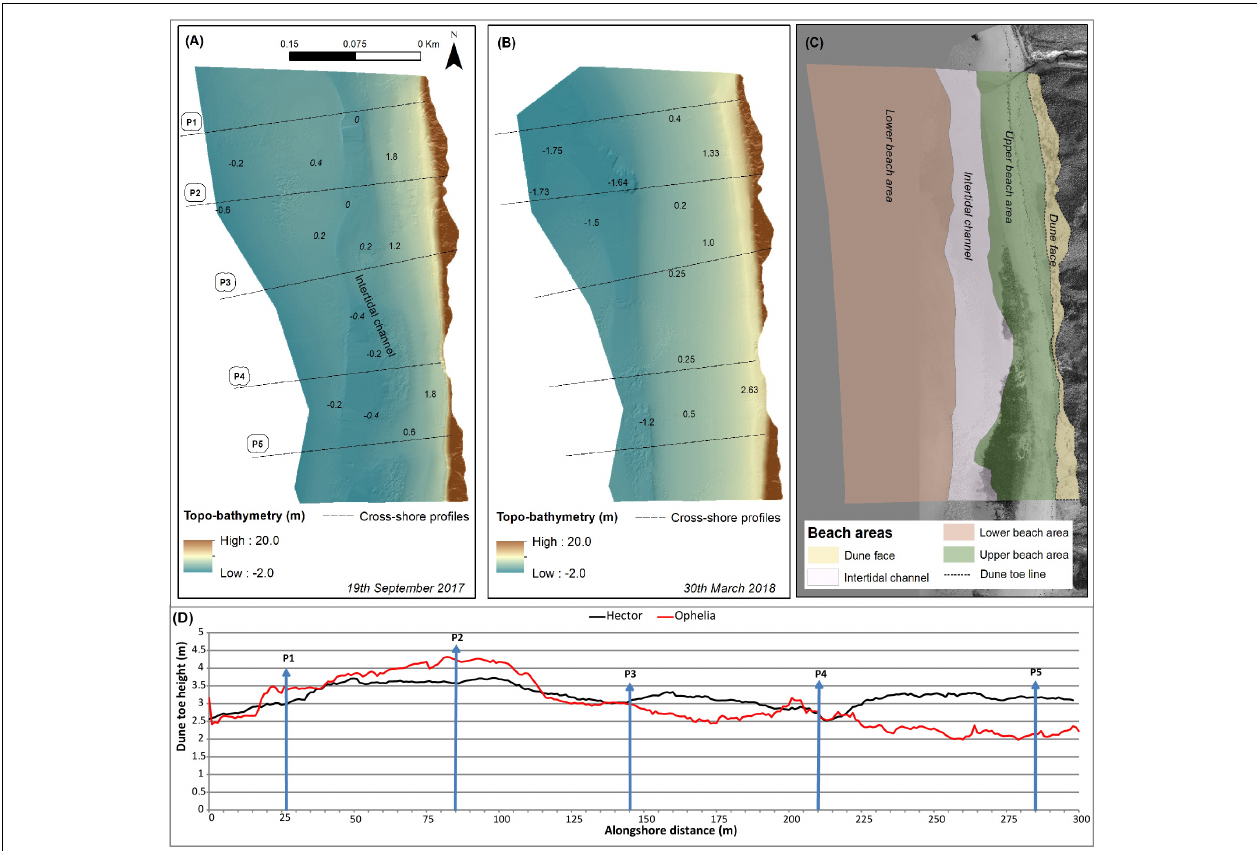
FIGURE 2 | Pre-Storm Ophelia (A) and Storm Hector (B) topo-bathymetries extracted from TLS surveys with numbers representing depths. Note differences in antecedent conditions of the submerged and subaerial beach at Five Finger Strand. (C) shows the subzones used for comparisons in the DoD analysis. (D) shows an alongshore section of dune toe height before Storm Ophelia (partially adapted from Guisado-Pintado and Jackson, 2018) and Storm Hector where the blue arrows represent the cross-shore